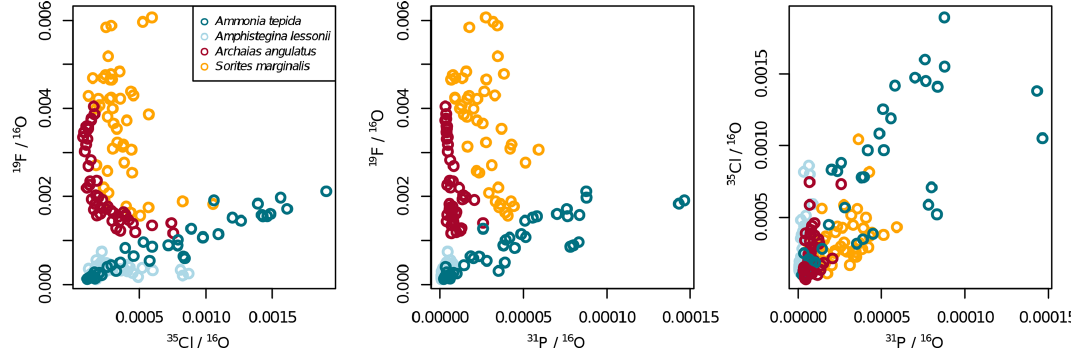
Figure A5. Illustration to show that the patterns in Fig. 2 do not change much when normalizing to 16 O instead of 40 Ca 16